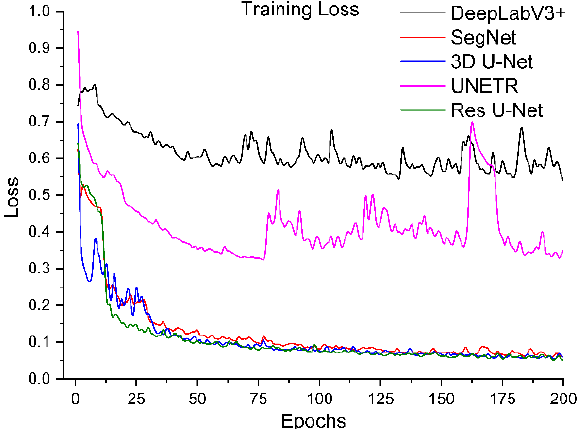
Figure 6. Training loss of segmentation networks trained with the proposed training scheme.